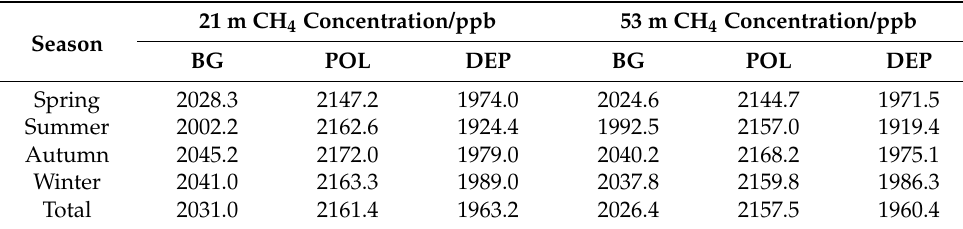
Table 1. Hourly CH 4 concentration at Lin’an Station from 2016 to 2020 after REBS